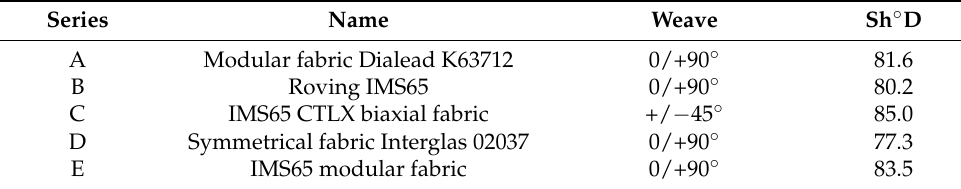
Table 11. Results of hardness measurements, made by the Shore’s